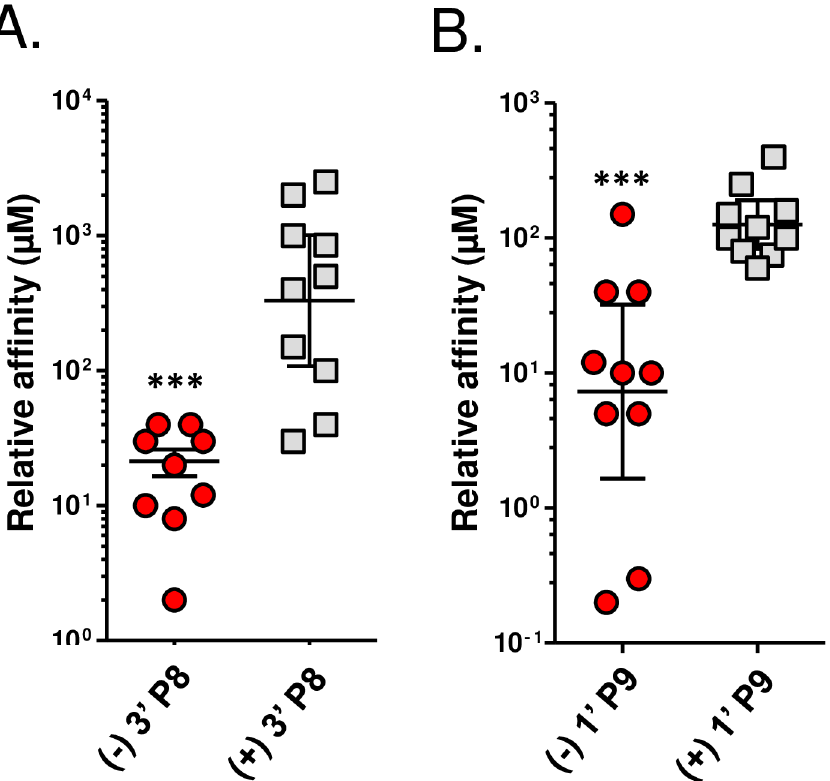
Fig 3. Relative nicotine binding affinities improve when using natural (-) enantiomers of two nicotine haptens. Day 56 serum was subjectedto a competitive ELISA assay using serially diluted(-) nicotine as the competitor. Comparisons betweengroups were conductedby unpaired t -test. *** p <